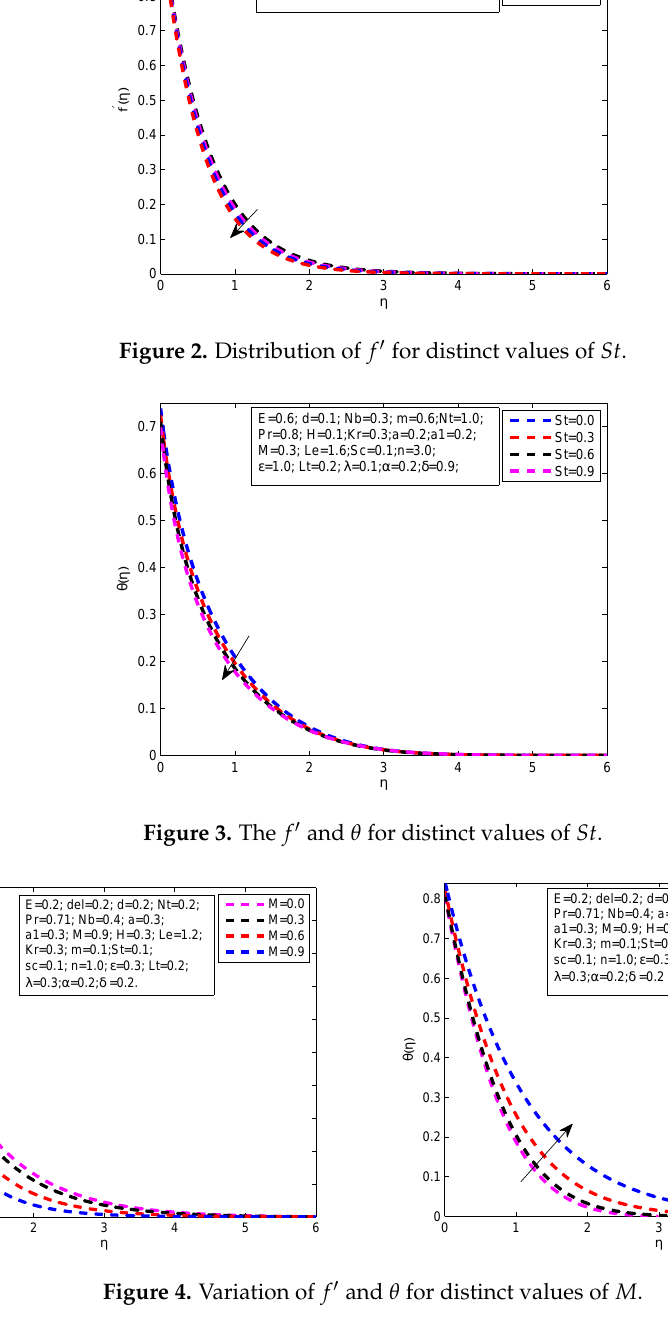
Figure 4. Variation of f (cid:48) and θ for distinct values of M